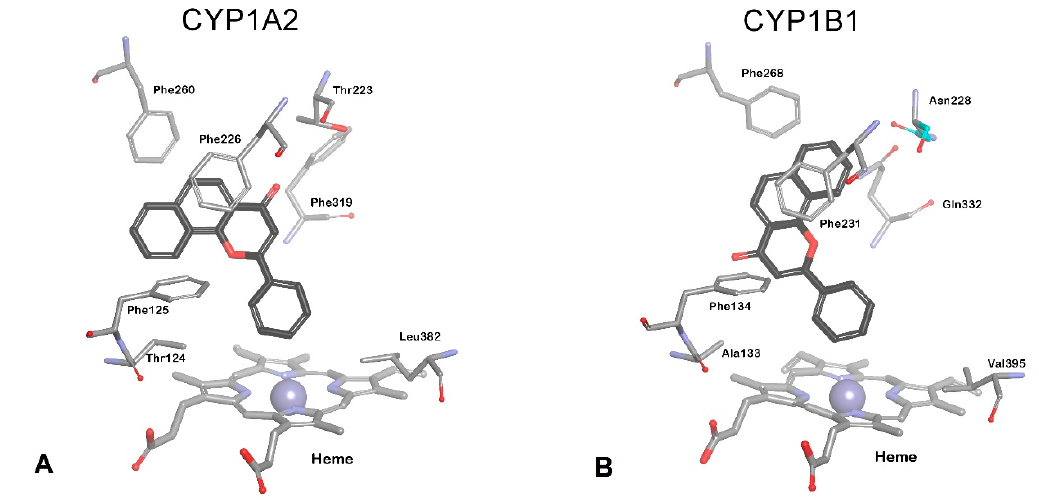
Figure 3. Orientation of ANF in: ( A ) CYP1A2 (PDB id: 2hi4) and ( B ) CYP1B1 (PDB id: 3pm0). ANF (rendered with black carbon atoms), heme, and residues are presented as stick models in atom type.